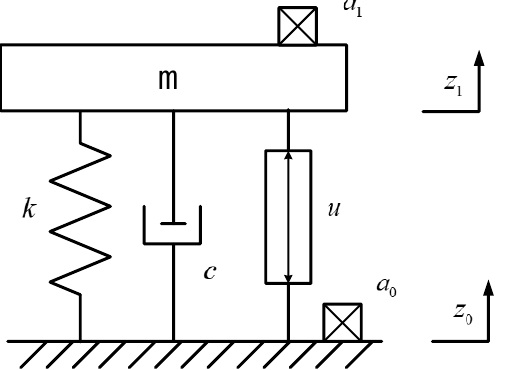
Figure 2. Schematic diagram of the vibration isolation module.